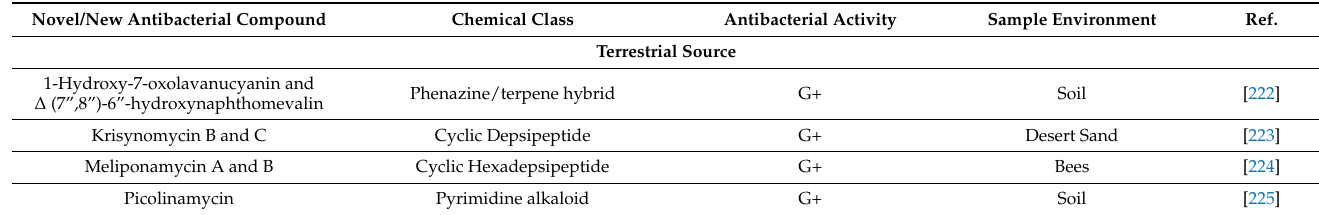
Table 9. Novel/new antibacterial bioactive compounds isolated from Streptomyces spp. between 2015 and